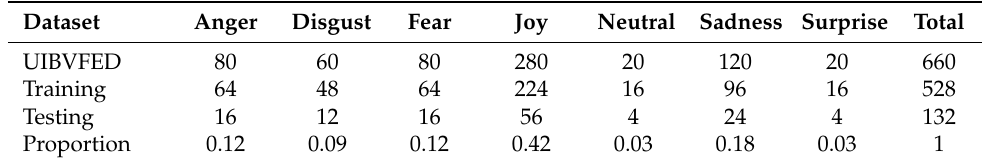
Table 3. Class distribution of the UIBVFED, training and testing